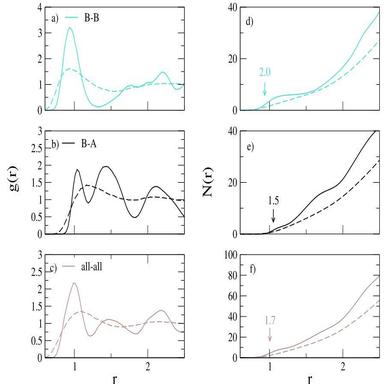
(a-c) The g(r) function for the lamellar-forming system ( = 0.5), and (d-g) the coordination number, the values of order()∕desorder() are indicated at the first-neighbor distances. The isotropic phase is represented by dashed lines and the ordered mesophase is represented by solid lines.